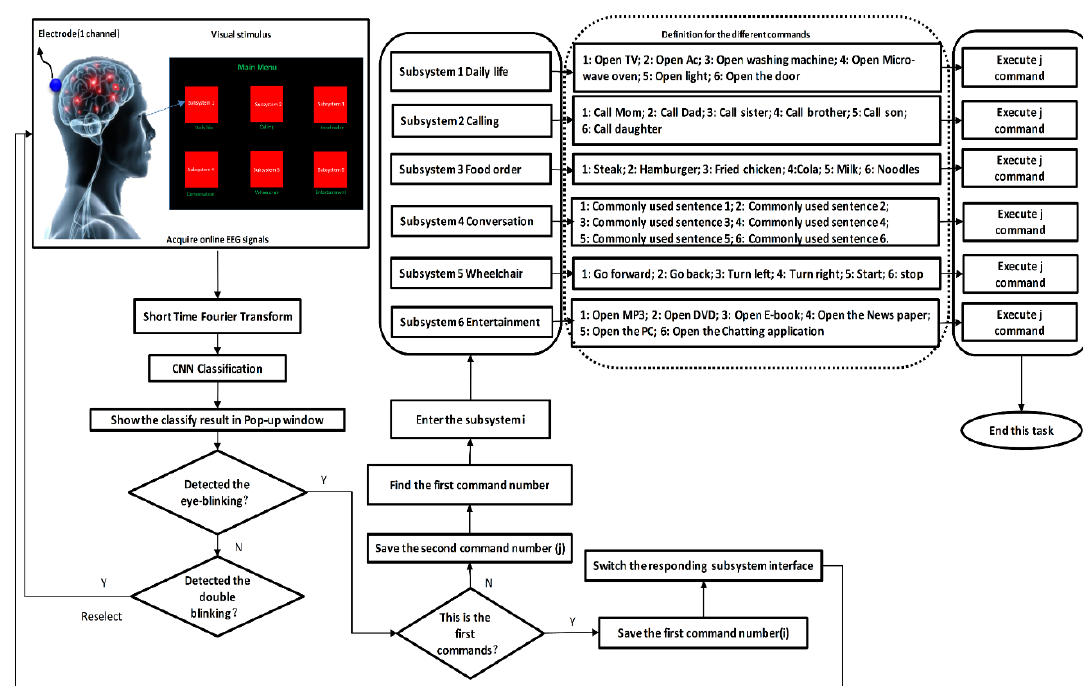
Figure 3. Control strategy for our hybrid BCI-based home automation system.